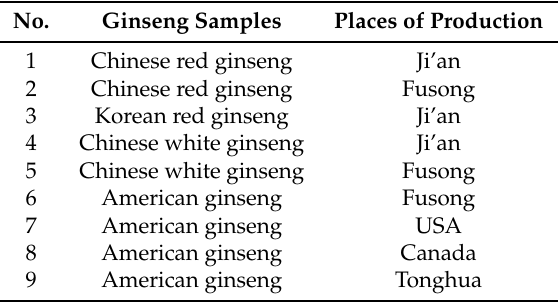
Table 1. Details of the ginseng samples.